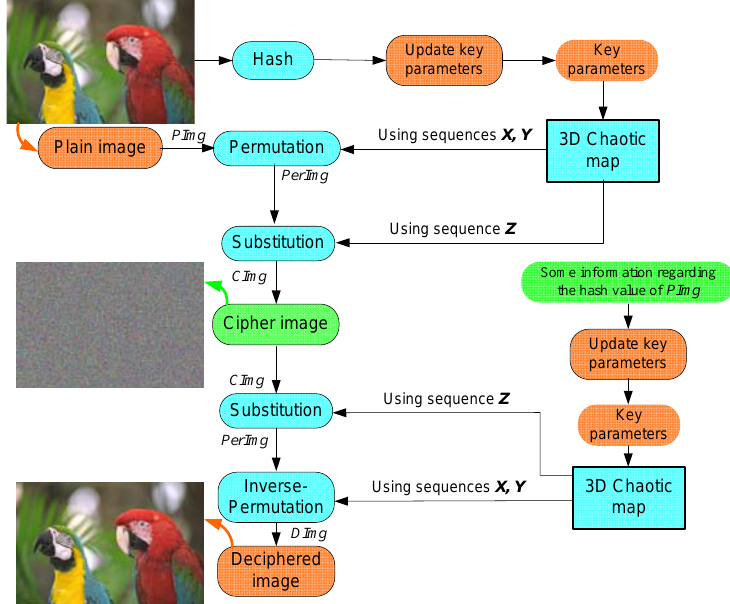
Figure 9. Description of the proposed cryptosystem for multimedia